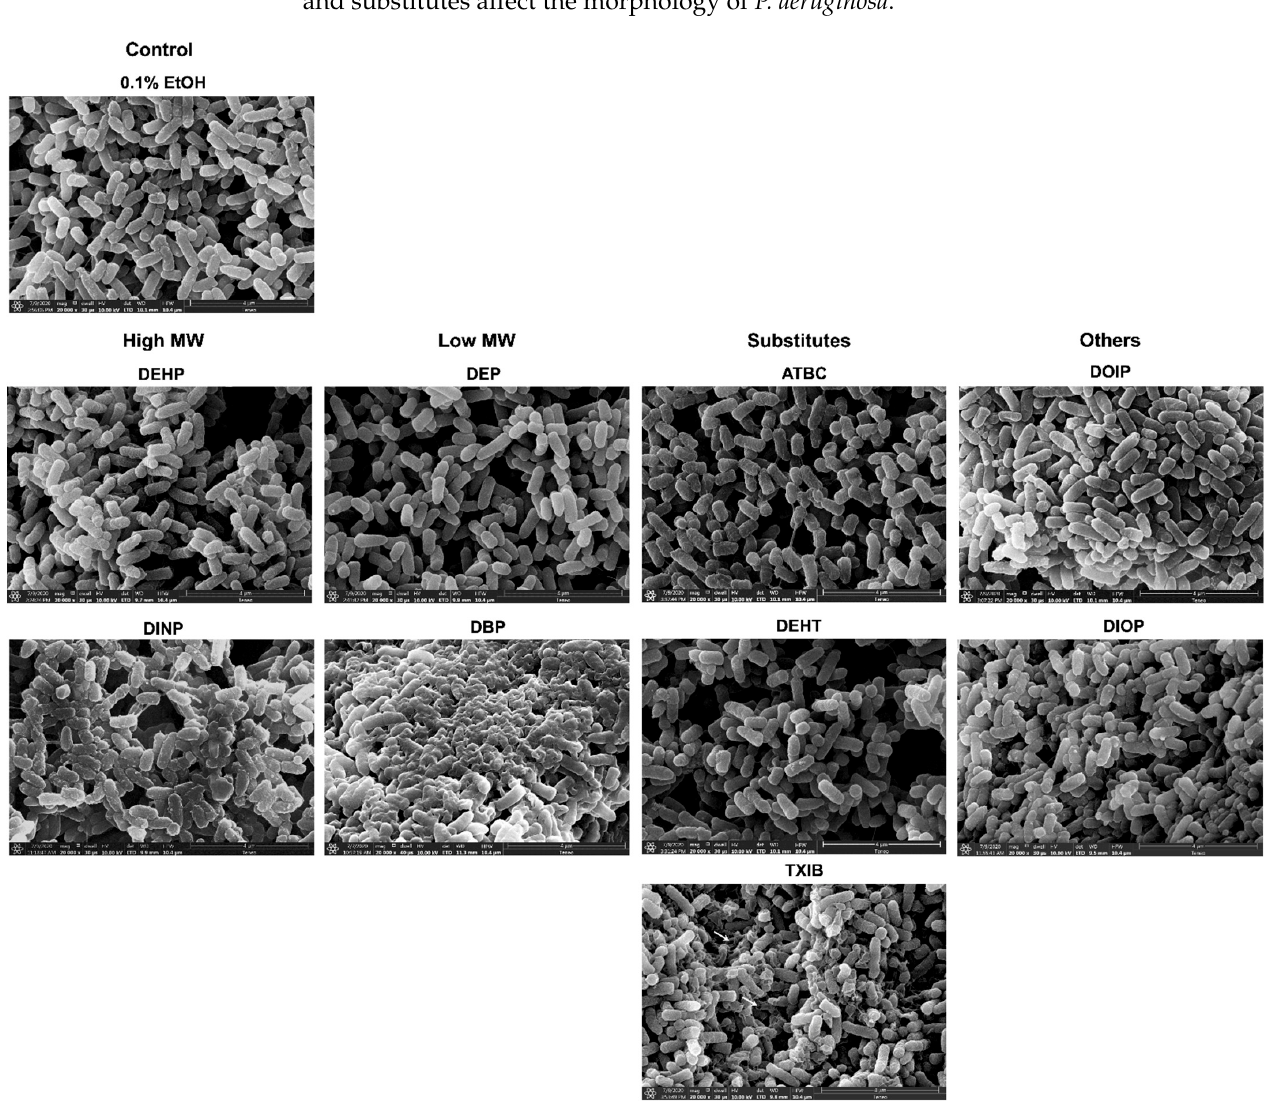
Figure 7. Some phthalates can alter the morphology of P. aeruginosa . Bacteria were observed by scanning electron microscopy after being grown for 24 h in M9 succinate medium under agitation in the presence of phthalates or substitutes at 10 − 3 M. The micrographs presented are representative of 10 images taken for each sample obtained from a biological duplicate. The white arrows indicate the presence of holes in the bacterial envelope. The magnification is ×20,000 and the bars represent 4 μ m.